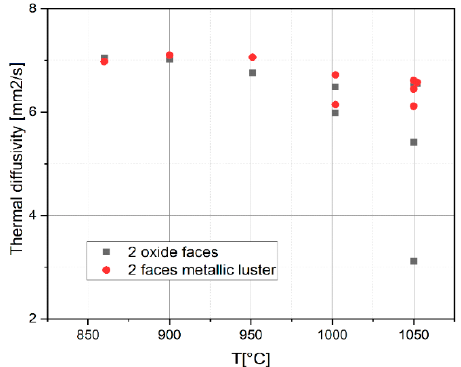
Figure 8. Thermal diffusivity values depending on the treatment temperature for the samples with both sides covered with oxide and with faces polished to metallic luster. The correlation of the thermal diffusivity values with the values of the grain size of the core is shown in Figure 9.